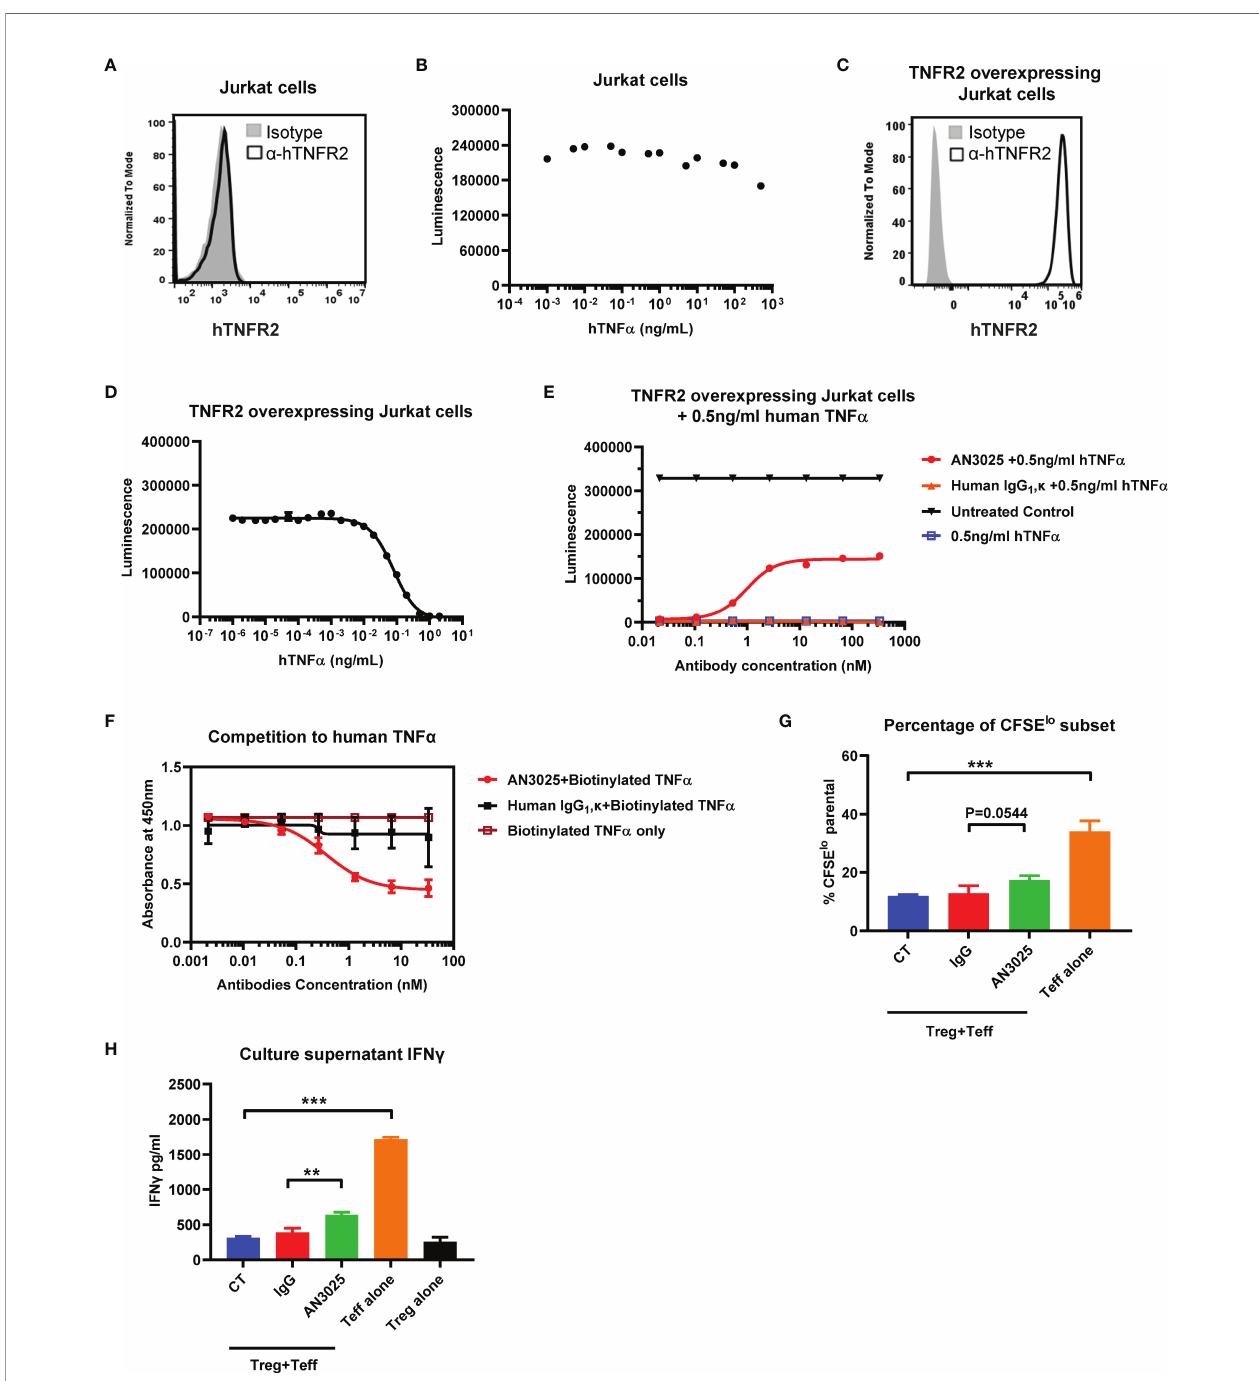
FIGURE 2 | AN3025 inhibits TNF a -TNFR2 mediated cell death of hTNFR2 overexpressing Jurkat cell and enhances T effector cell function in Tregs/Teff co-culture assay. (A) Expression of human TNFR2 on wildtype Jurkat cells. (B) Viability of wildtype Jurkat cells after stimulation with titrated human TNF a . (C) Expression of human TNFR2 on established hTNFR2 overexpressing Jurkat single cell clone. (D) Viability of hTNFR2 overexpressing Jurkat cells after stimulation with titrated human TNF a . (E) Viability of hTNFR2 overexpressing Jurkat cells after stimulation with constant 0.5ng/mL human TNF a in the presence of titrated AN3025 or titrated human IgG 1 , k . (F) Competitive ELISA binding assay of AN3025 with biotinylated human TNF a to human TNFR2 on plate. (G, H) Human iTregs were co-cultured with CFSE-labeled autologous CD4 + Teff cells for 4 days. (G) CFSE lo T effector cell percentage was quanti fi ed by fl ow cytometry. (H) IFN g in the supernatants was detected by ELISA assay. Values were expressed as Mean ± SEM. **P < 0.01; ***P <